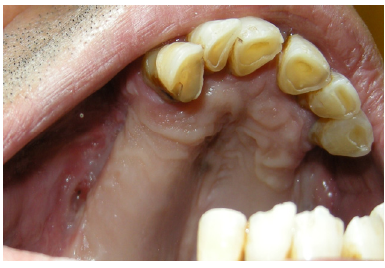
Figure 15. After two months.